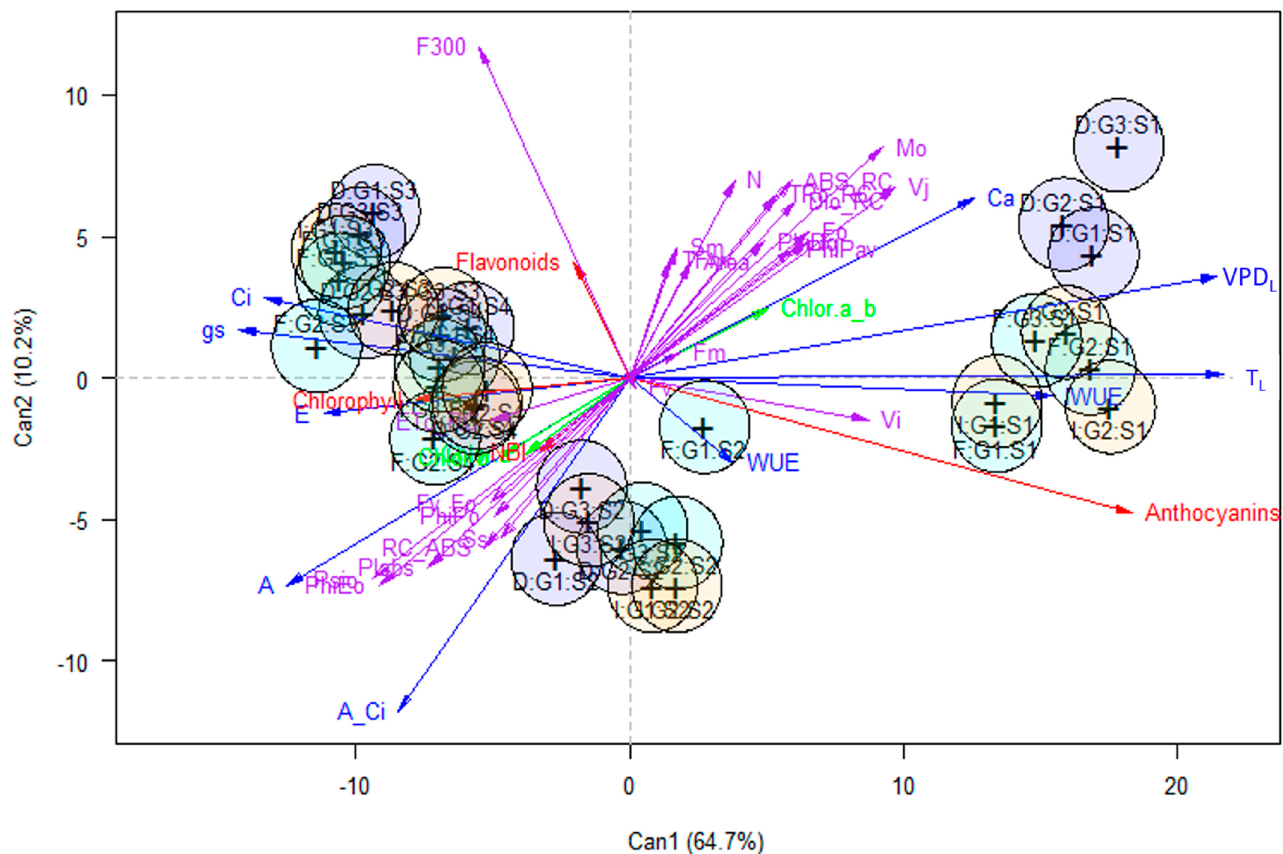
Figure 2. Biplot containing mean scores of the first two canonical (Can. 1 and Can. 2) discriminating variables constructed from gas exchange variables, chlorophyll and pigment indices, and chlorophyll a fluorescence trait. The 95% confidence ellipses for the combinations of system, clone, and period are shaded. (Systems: F—fertigation, I—irrigation, D—dryland farming;